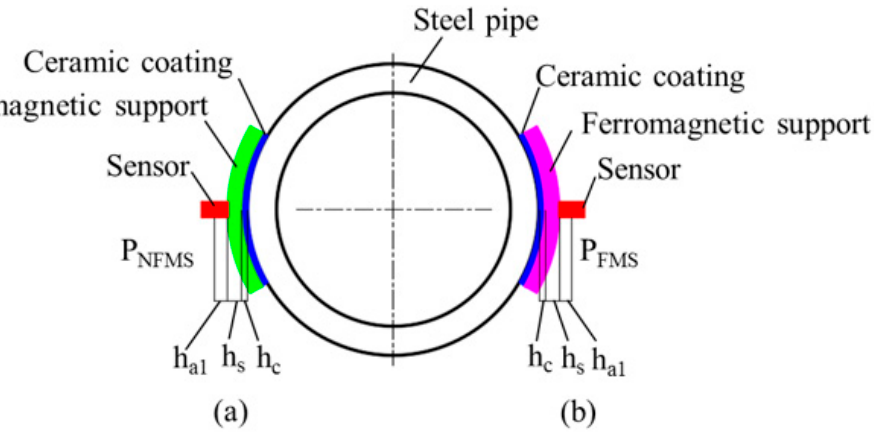
Figure 1. The magnetic flux leakage (MFL) inspection apparatus for steel pipe.